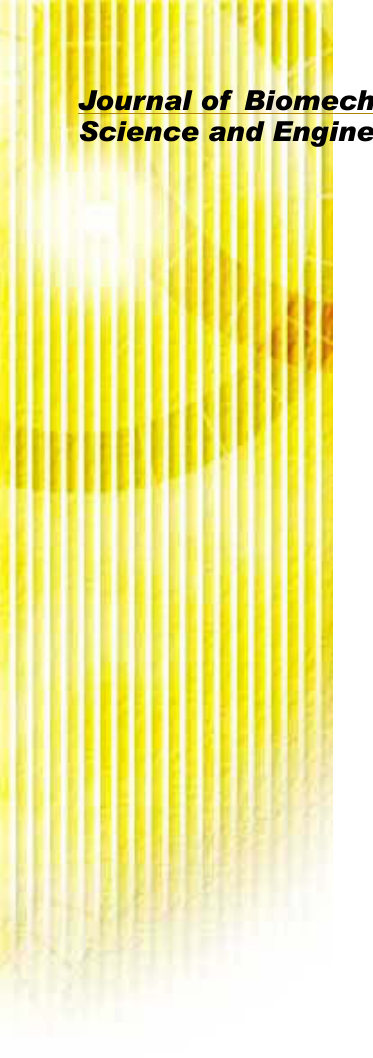
Fig. 6 Changes in the bulk density of the tissue-engineered bones with culture period. Solid line: primary-cultured osteoblasts, Dash line: MC3T3-E1 cells. Data represent the mean ± SD (n = 4). *p < 0.0001 versus MC3T3-E1.